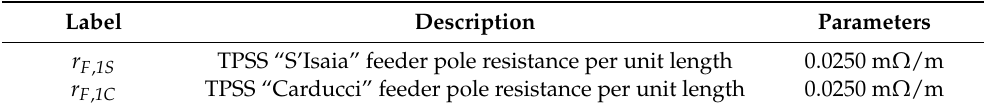
Table 3 collects the resistive parameters of the FS 1 feeding wiring harness. Table 3. Feeding cables resistance per unit length of FS 1.